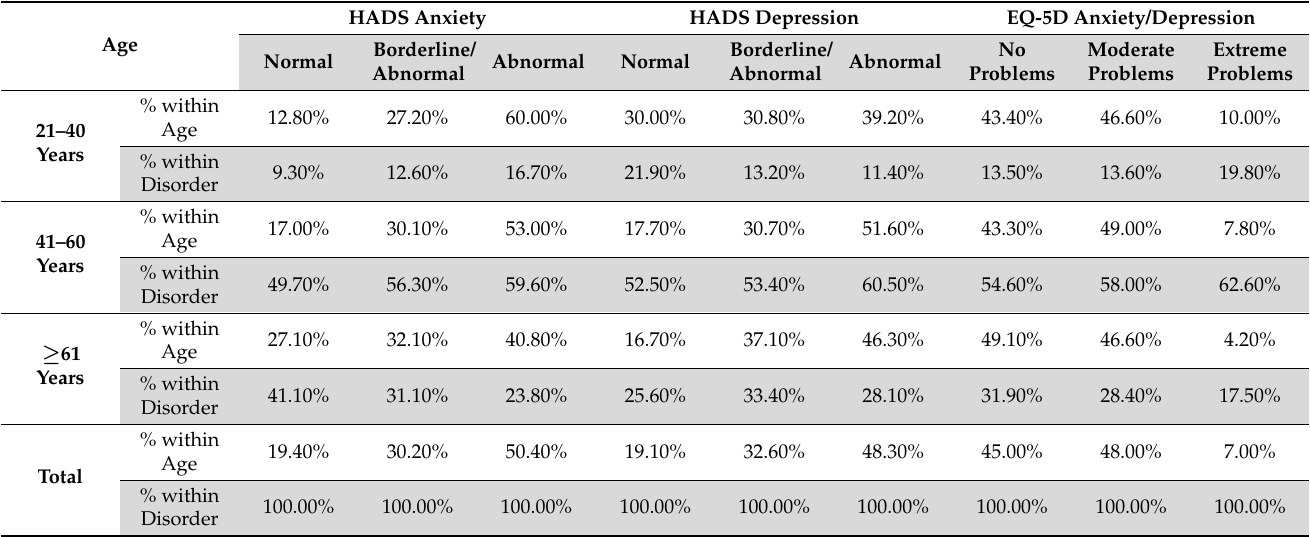
Table 5. Statistics showing anxiety and depression frequencies according to age